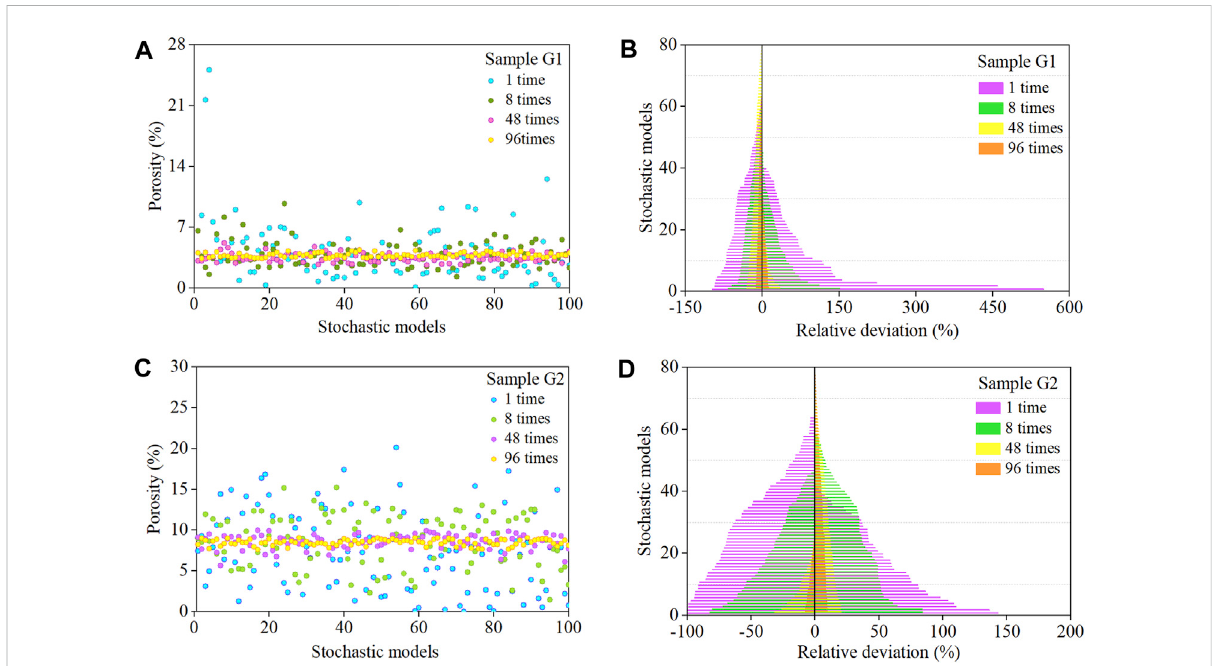
FIGURE 7 (A) Porosity distribution and (B) porosity relative deviation distribution of the conventional small-size FIB-SEM (10 μ m × 10 μ m × 10 μ m) stochastic models (1x) and 8x, 48x, and 96x upsized stochastic models for Sample G1. (C,D) porosity distribution and the porosity relative deviation distribution plots for Sample